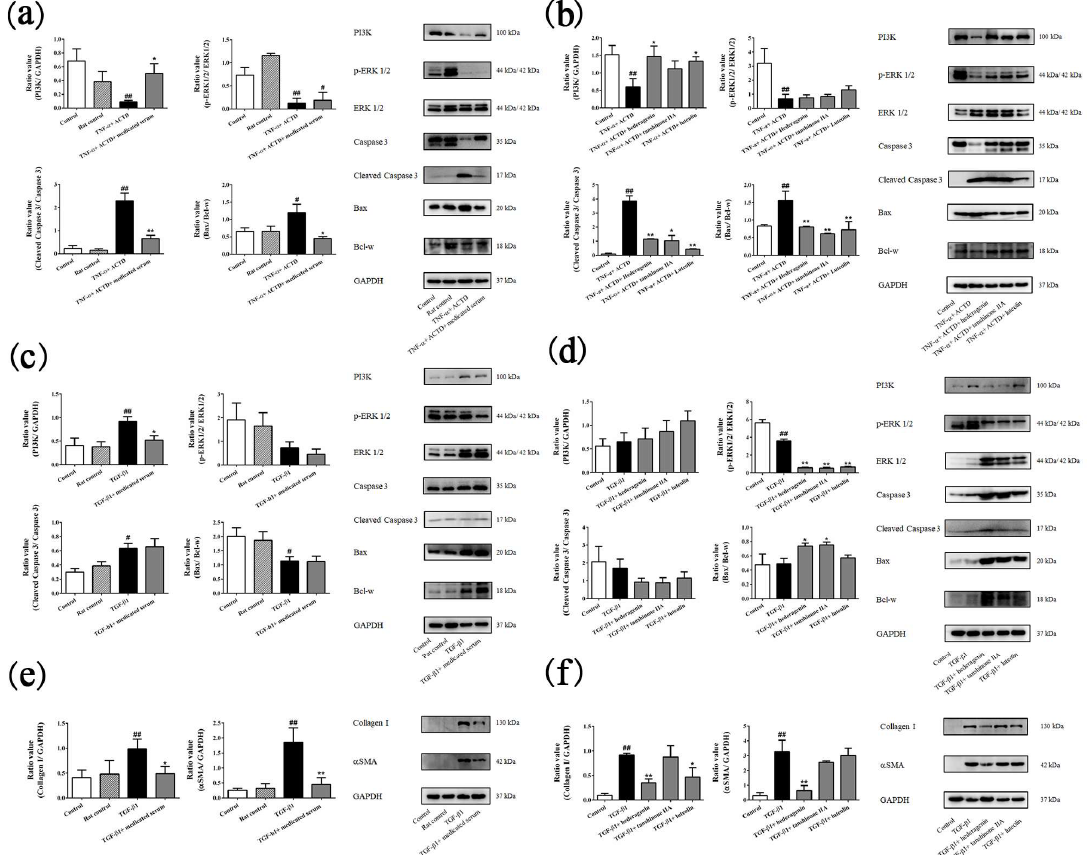
Figure 5. Validation of potential targets with western blot. ( a ) Effects of FZHY-medicated serum on the expression of potential targets in L02 cells. ( b ) Effects of tanshinone IIA, hederagenin and luteolin on the expression of potential targets in L02 cells. ( c ) Effects of FZHY-medicated serum on the expression of potential targets in Lx2 cells. ( d ) Effects of tanshinone IIA, hederagenin and luteolin on the expression of potential targets in LX2 cells. ( e ) Effects of FZHY-medicated serum on the collagen I and α SMA levels in Lx2 cells. ( f ) Effects of tanshinone IIA, hederagenin and luteolin on the collagen I and α SMA levels in Lx2 cells. FZHY, FZHY formula. # p < 0.05, ## p < 0.01, compared with the control group. * p < 0.05, ** p < 0.01, compared with the model group. These groupings of blots are cropped from the same gel or different gels. The full-length gels and blots are included in a Supplementary Information file (Supplementary Figure S1). Repeated 3